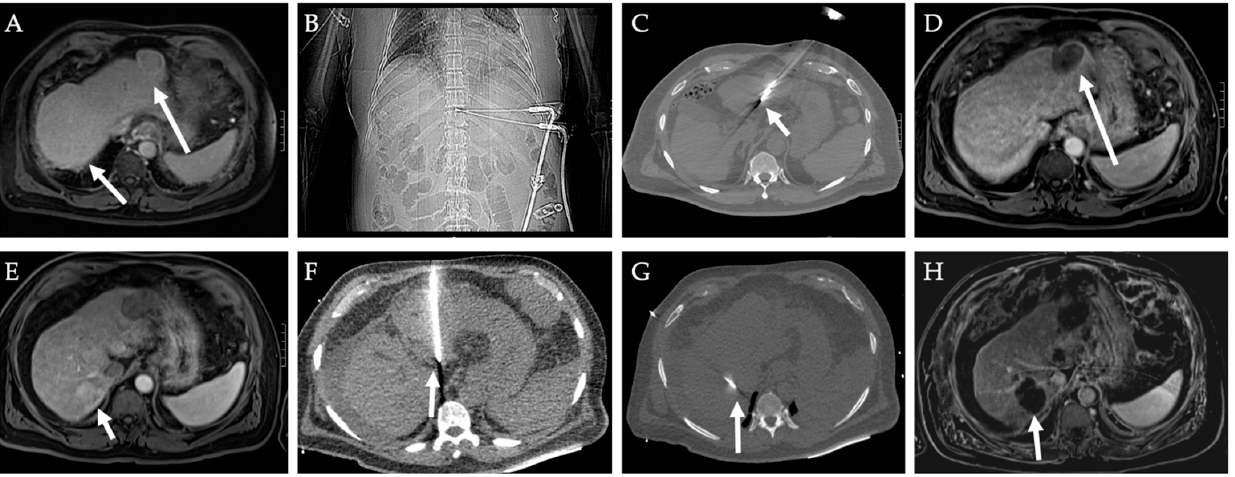
Figure 9. Microwave ablation and irreversible electroporation of hepatocellular carcinoma . A 72- year-old male with alcohol-induced cirrhosis and HCC was found to have a 3.5 × 2.6 cm biopsy-proven HCC lesion (white arrow) in segment II ( A ), LI-RADS 4 lesion in segment VII, and LI-RADS 3 lesion in the caudate lobe on MRI. ( B , C ) The patient underwent percutaneous MWA of the segment II